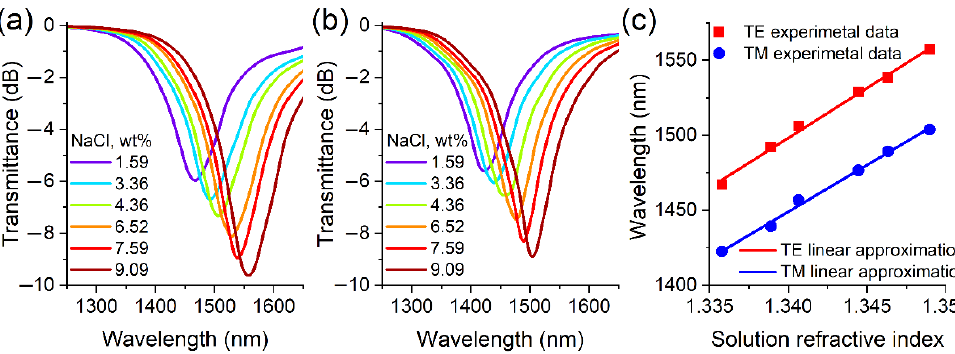
Figure 12. Transmission spectra of thinned optical fibers coated with zinc telluride when immersed in aqueous solutions of sodium chloride in the case of observation of the first ( a ) TE and ( b ) TM LMRs. ( c ) Dependences of the resonance maximum wavelength on the environment refractive index. Table 1. Comparison of sensitivity to NaCl concentration of fiber refractometers based on the LMR effect. Coating